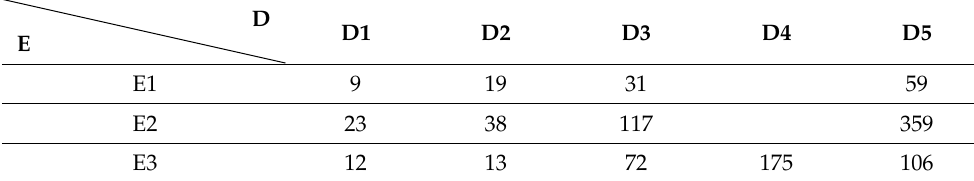
Table 5. Matrix of numerical relation between type of element and type of